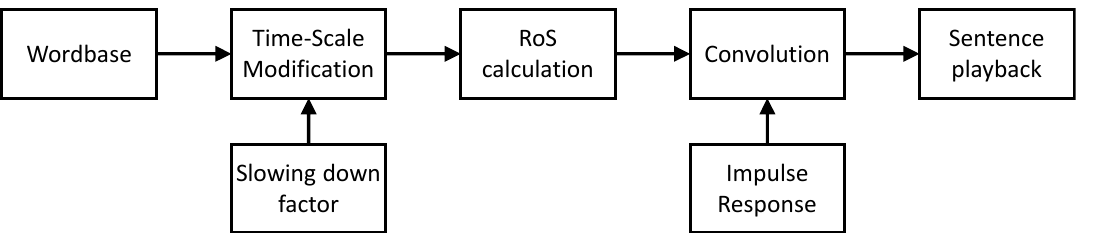
Figure 1. Flowchart of the sentence formation process.